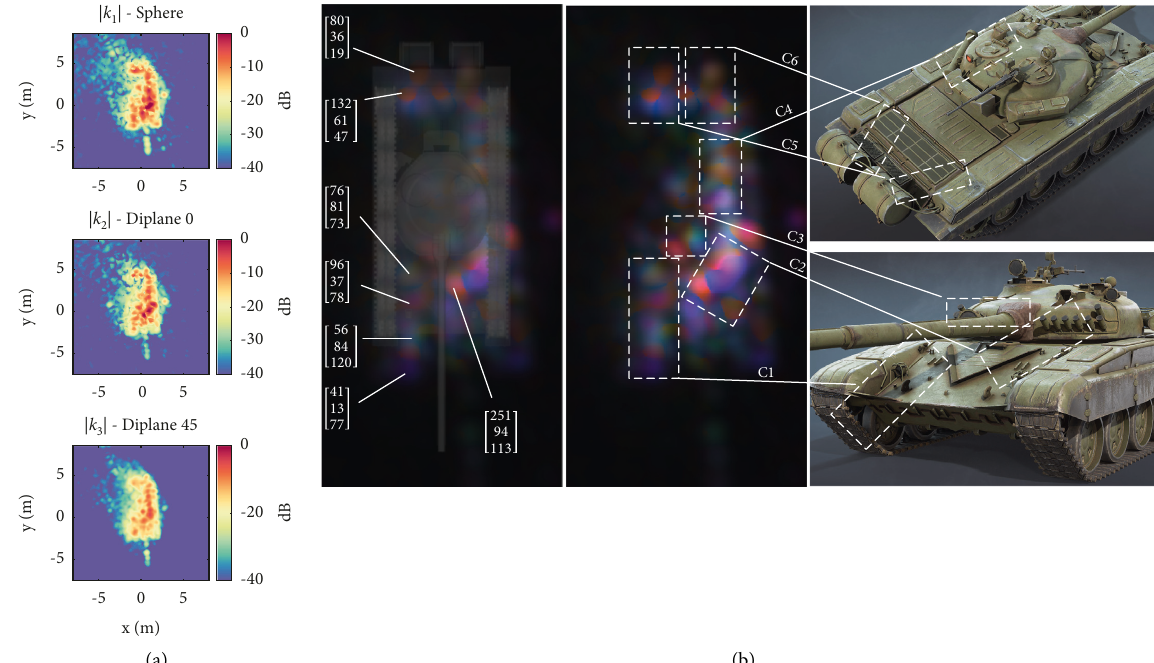
rel computed from the angularly averaged covariance matrix S [ ]